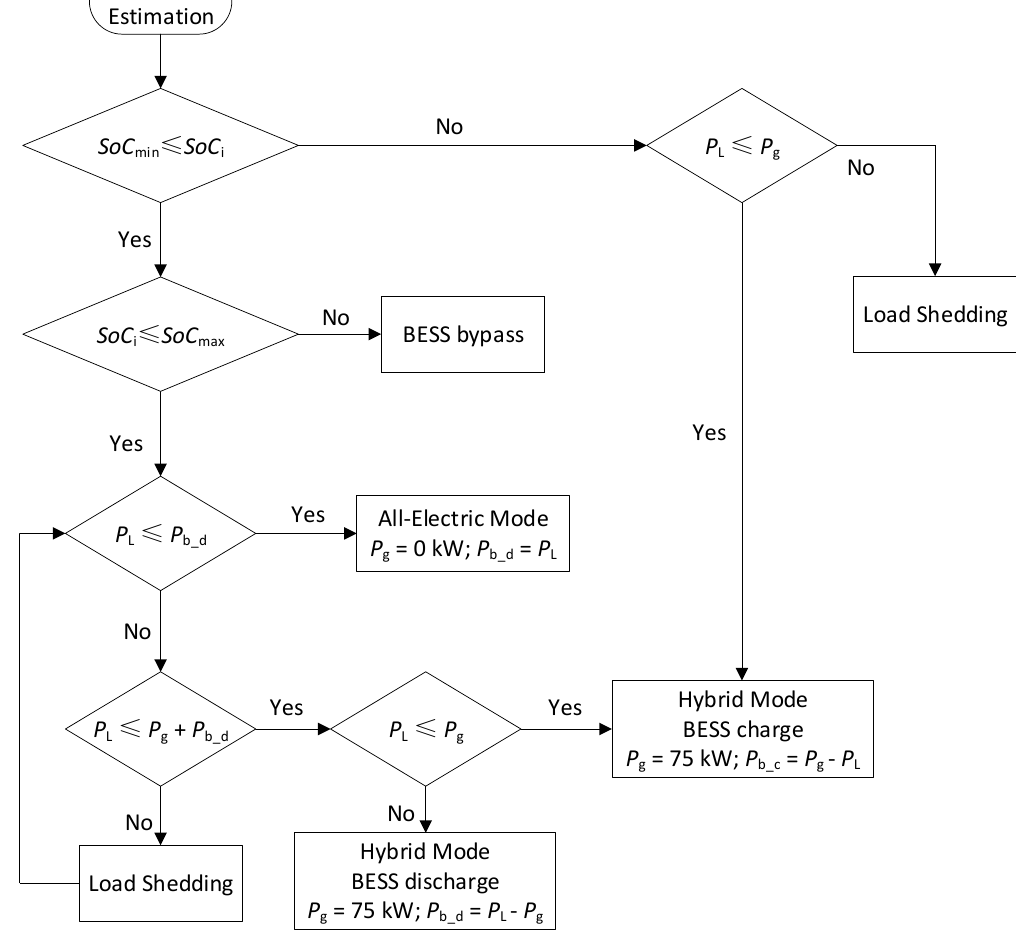
Figure 2. Flowchart for the selection of different operation modes.